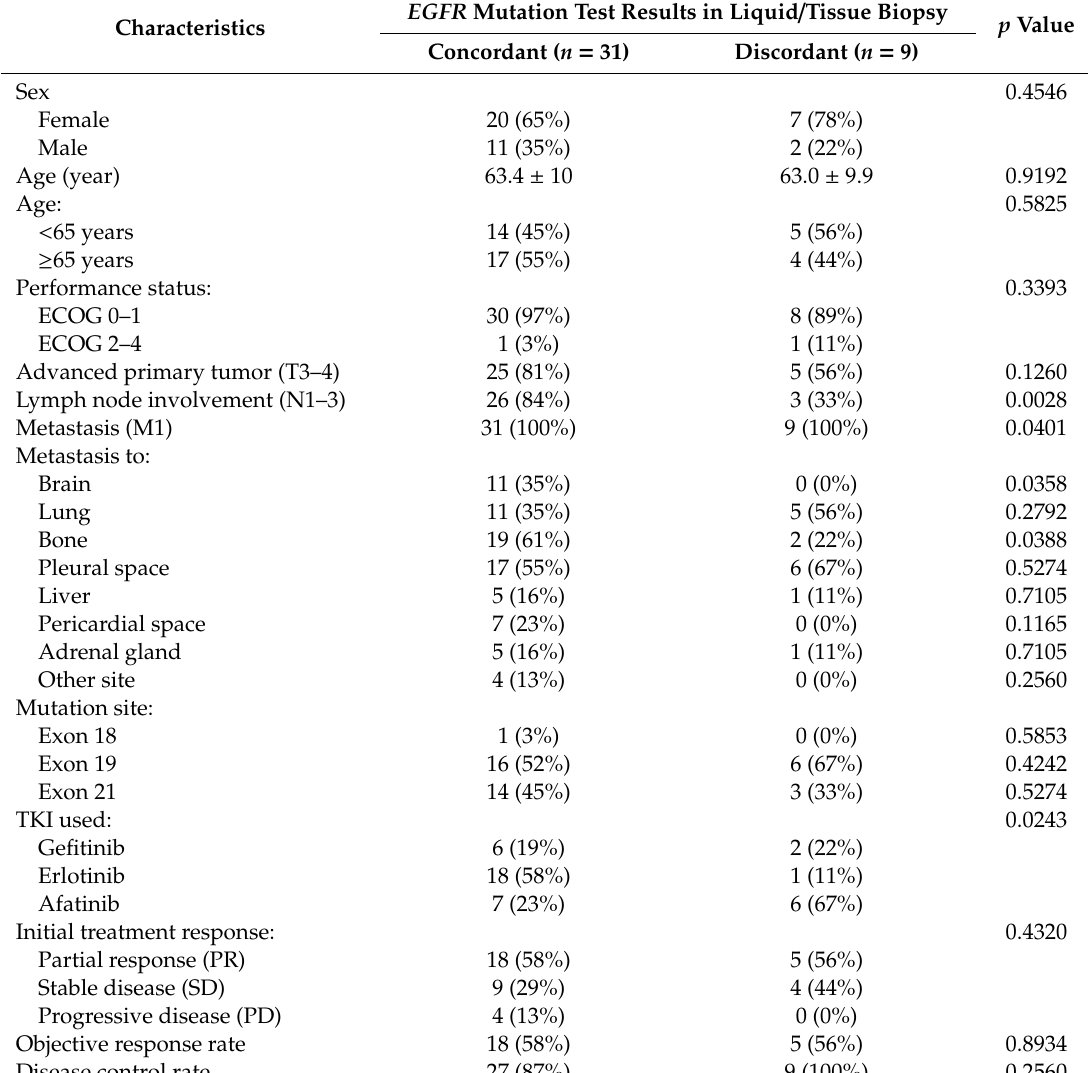
Table 3. Characteristics of the stage IV patients receiving first-line EGFR